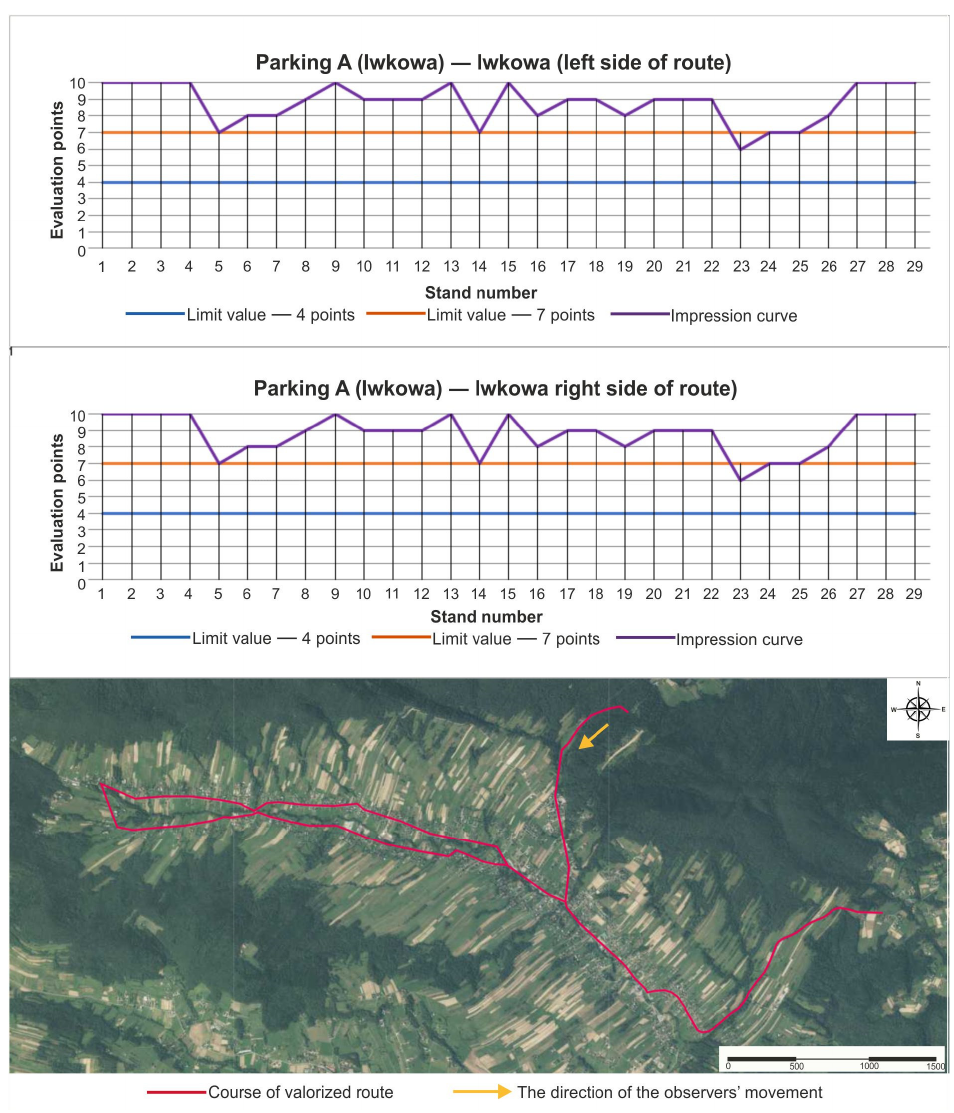
Figure 13. Impression curves for the Parking A (Iwkowa)—Iwkowa route (Iwkowa Commune). Route 2: Iwkowa—Połom Mały—Por ˛abka Iwkowska—Dru˙zk ó w Pusty. The